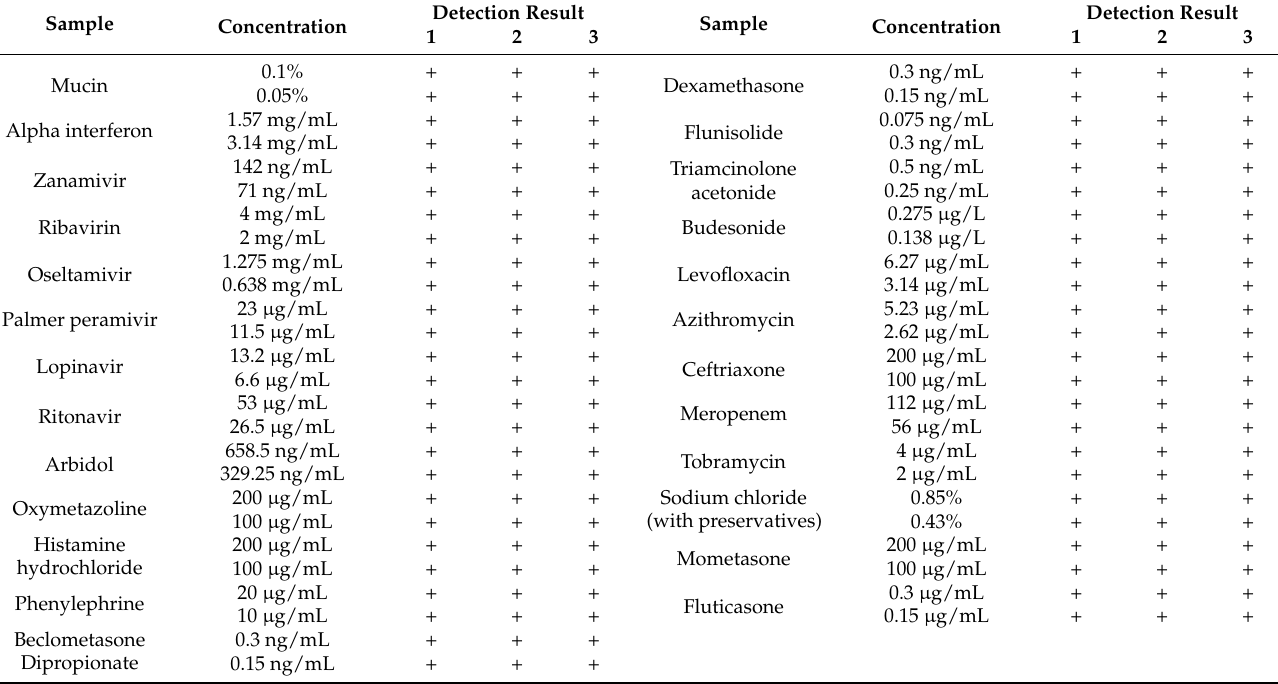
Table 6. Influence of interfering substances on positive